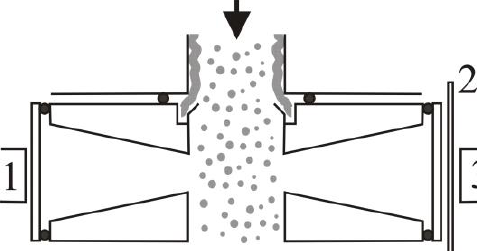
Figure 2. Schematic representation of liquid film removal arrangement using slot modification of the column based on [11]. 1 — digital camera, 2 — screen, 3 — flash lamps.